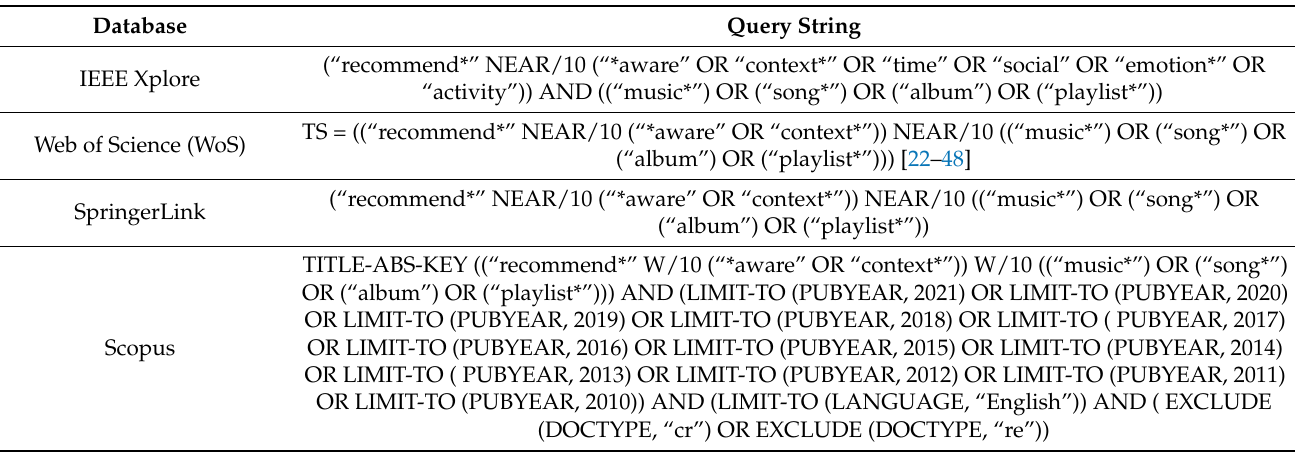
Table 1. Databases and query